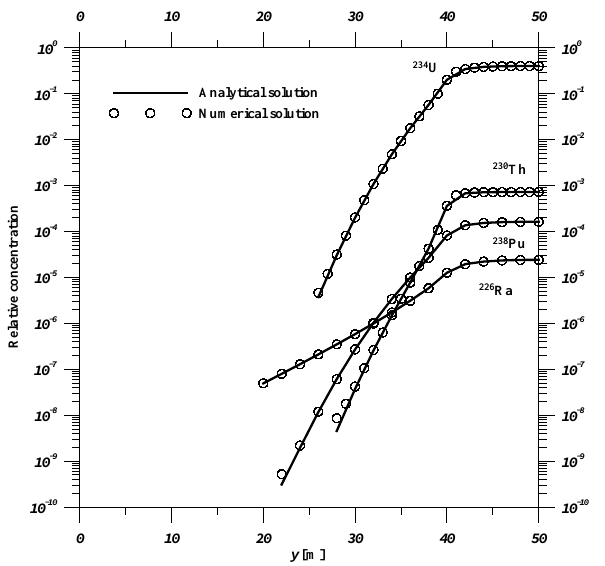
Fig. 3. Figure 3. Comparison of spatial concentration profiles of four species along the transverse direction ( = 0m) at t = 1000years ob- tained from derived analytical solutions and numerical solutions for convergence test example 1 of four-member radionuclide decay chain 238 Pu → 234 U → 230 Th → 226 Ra.